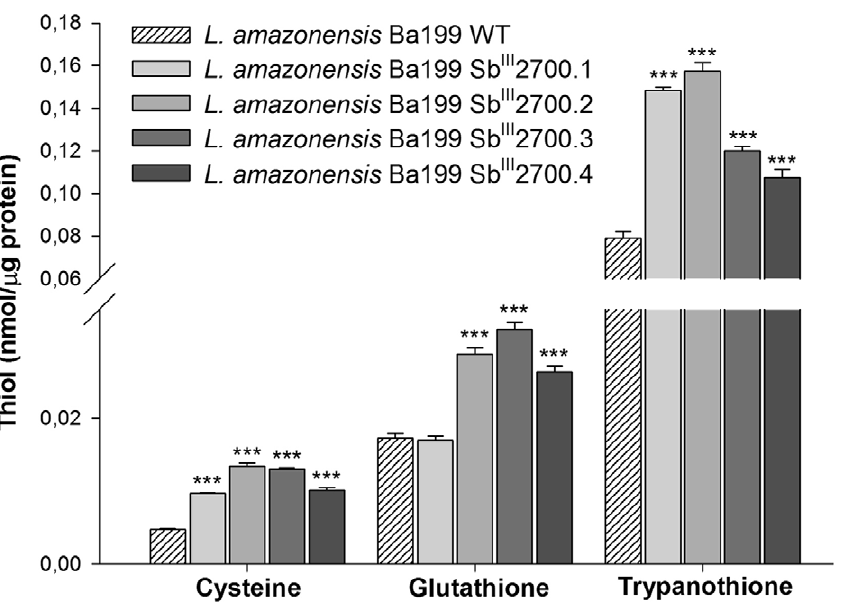
Figure 5. Intracellular levels of thiols in L.amazonensis antimony resistant mutants. Thiols were derivatized with monobromobimane and separated by HPLC coupled with a fluorescent detector. Values are representative of two experiments performed in triplicate. Asterisks indicate statistically significant changes compared with Ba199 WT. The data were analyzed by one-way ANOVA followed by Dunnett’s multiple comparison test. *** = p , 0.01.